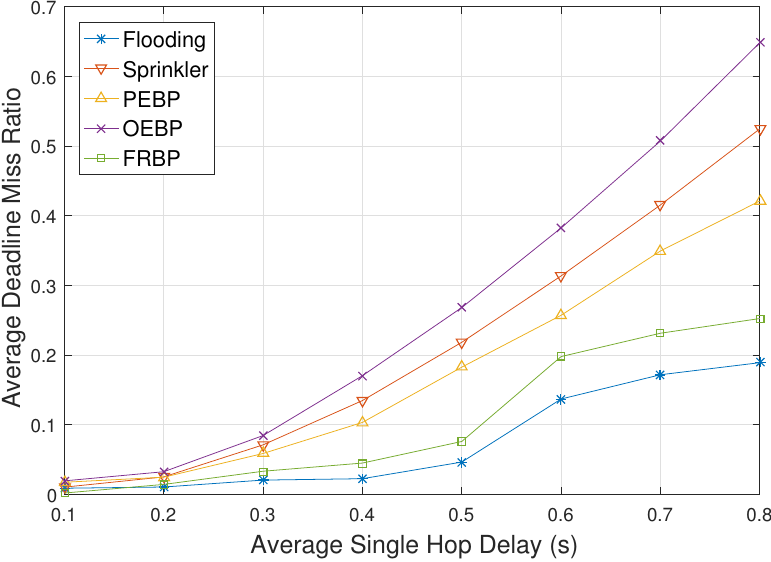
Figure 6. Deadline missed ratio impacted by single hop